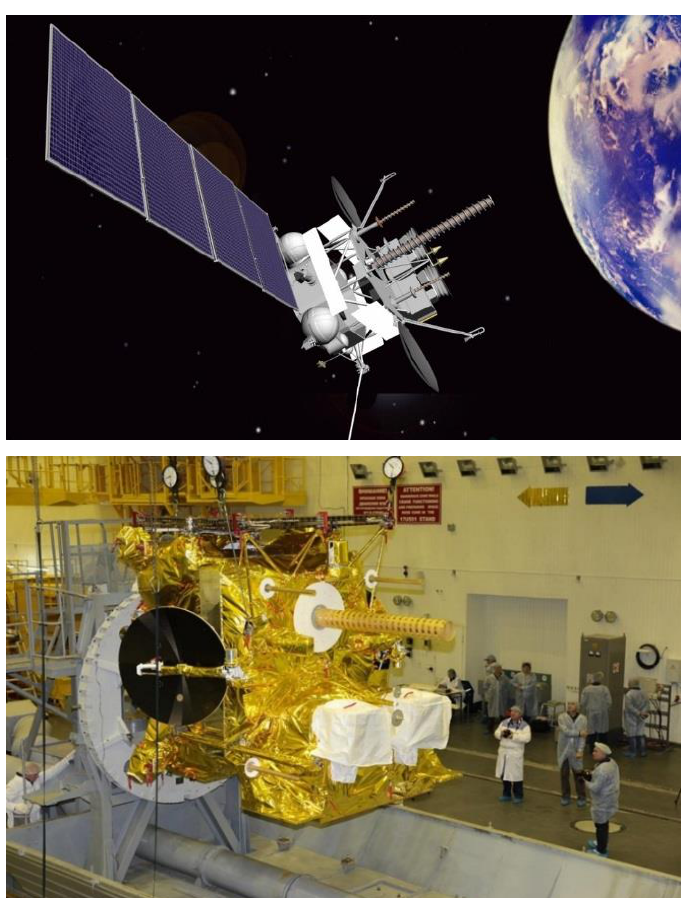
Fig. 1. Geostati onary SC “Electro -L ”